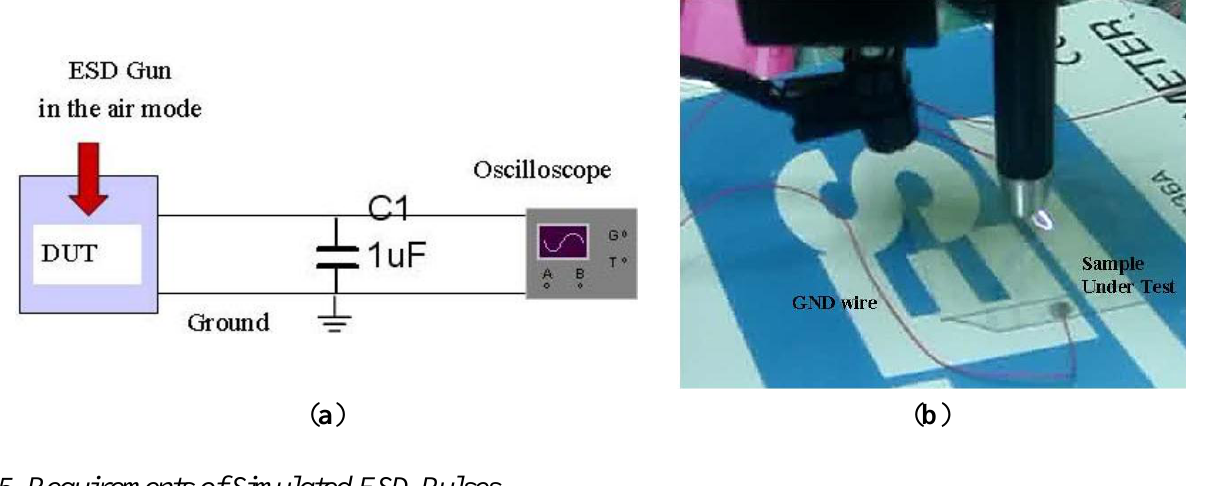
Figure 5. Setup of the electrostatic discharge (ESD) test: ( a ) schematic setup; and ( b ) in situ testing under discharge with a high-voltage electrical gun (HV